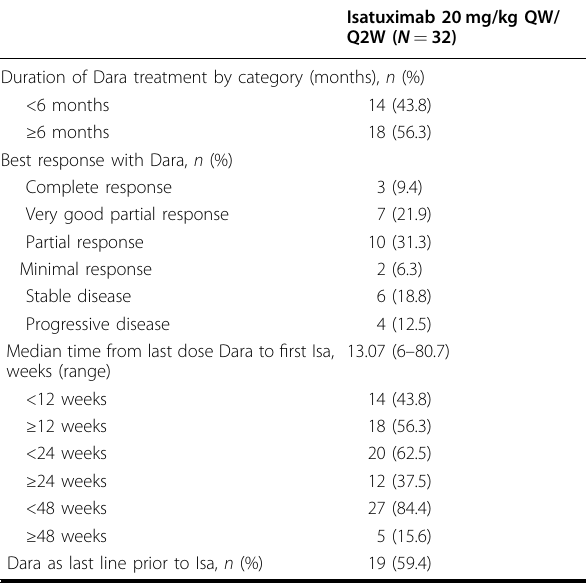
Table 1 Baseline patient characteristics at study entry in the all-treated